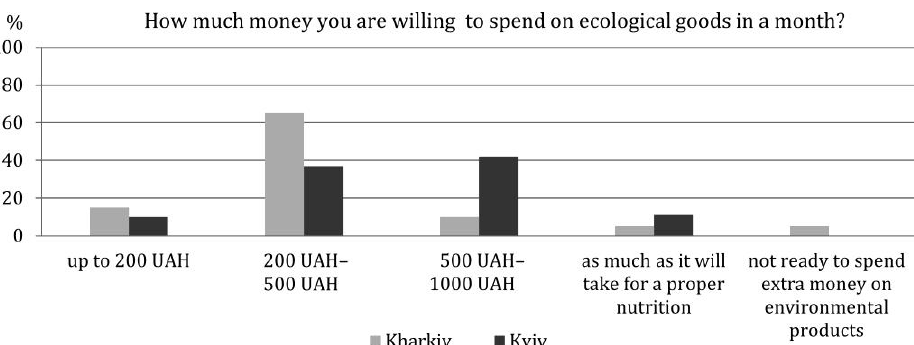
Fig. 9. The willingness of respondents to pay for ecological goods (Source: author's research)